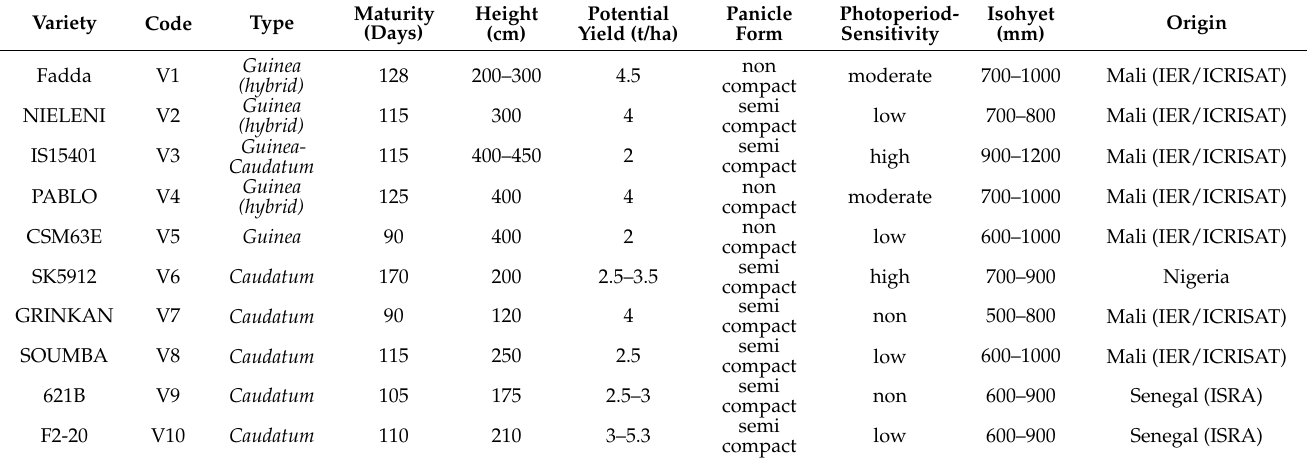
Table 1. Characteristics of the varieties used in this study and their